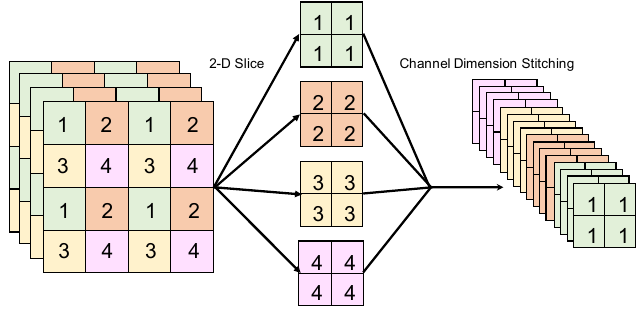
Figure 5. Schematic diagram of first-order feature reconstruction.